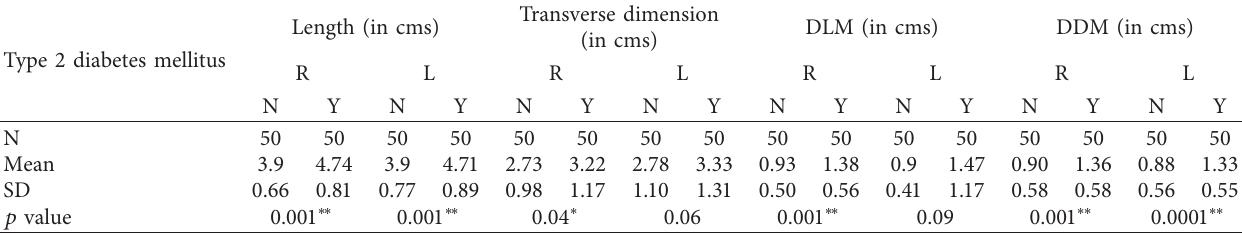
Table 1: Comparison between ultrasonographic measurements in study subjects (type 2 diabetes mellitus) and control subjects. Type 2 diabetes mellitus